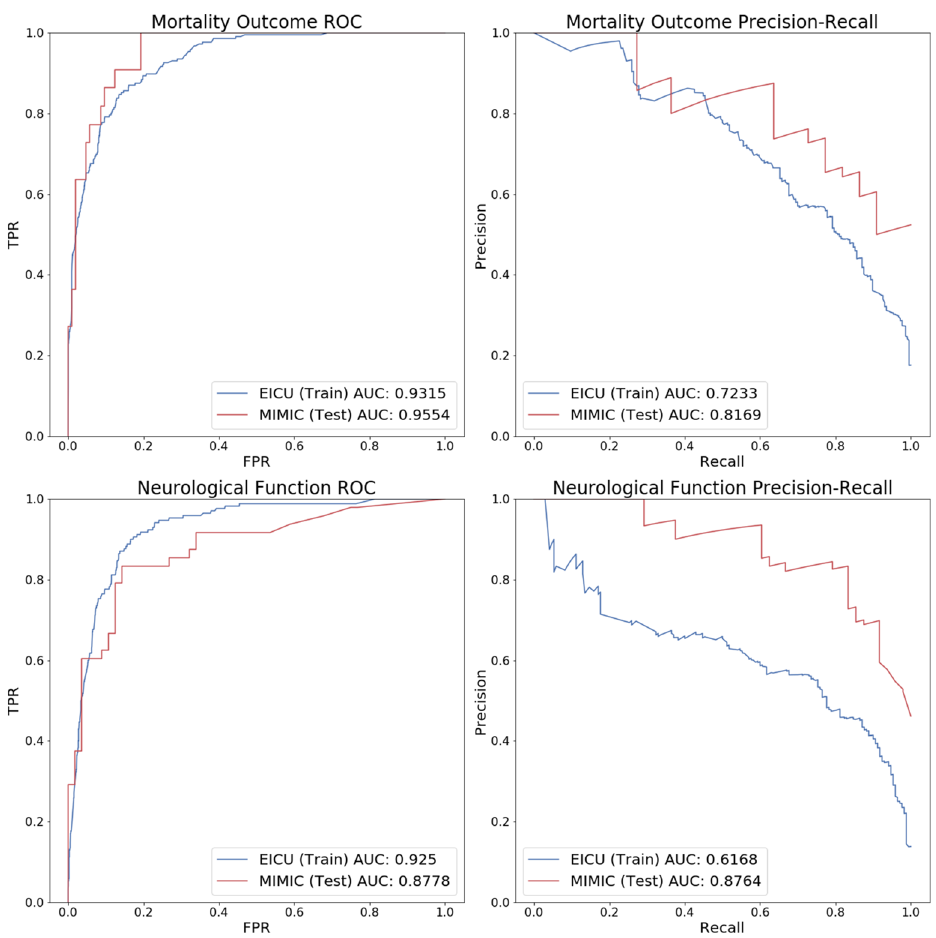
Figure 3. External validation. The blue line corresponds to results on the entire eICU data set, which is used to train the model, while the red line corresponds to results on the MIMIC-III patients, which are not used by the model until test-time. ROC, Receiver operating characteristic. AUC area under the curve, TPR true positive rate, FPR false positive rate, GCS Glasgow Coma